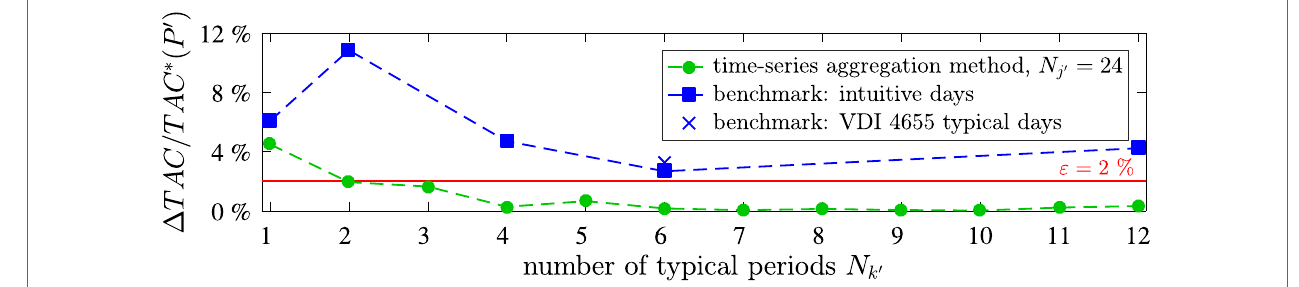
FIGURE 9 | Normalized accuracy measure ∆ TAC divided by total annualized cost of the aggregated synthesis problem TAC *( P ′ ) as function of number of typical periods N k ′ with N j =24 segments. Benchmark periods based on intuitive selection of typical periods ( N k =1: spring day, N k =2: summer and winter day, N k =4: 1day per season, N k =6: 1day for every second month, and N k =12: 1day per month) and selection of N k =6 typical days according to VDI